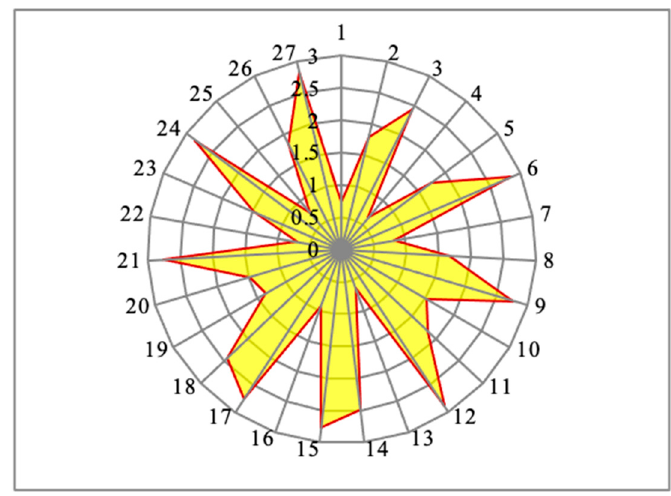
Figure 29. Outcomes of surface roughness (µm) for each specimen in a radar diagram.